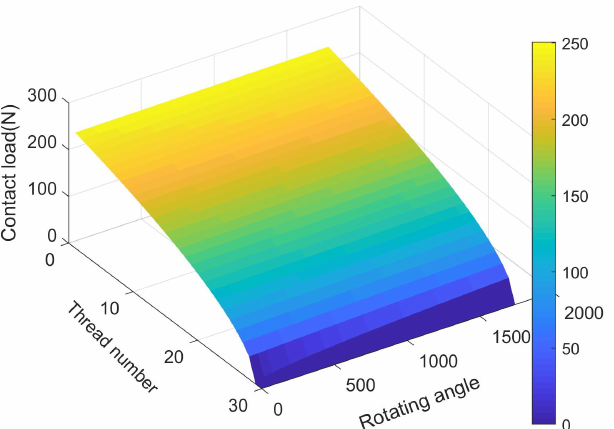
Figure 11. Contact load distribution cycling process without radial load of case